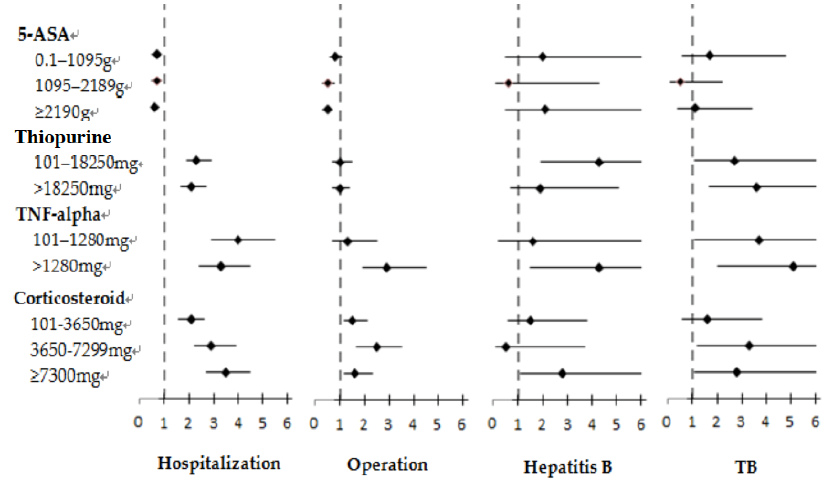
Figure 2. HRs and 95% CIs for hospitalization, operation, hepatitis B, and TB activation among patients with IBD in association with various medications. Dosage less than 100 mg is the reference group for each